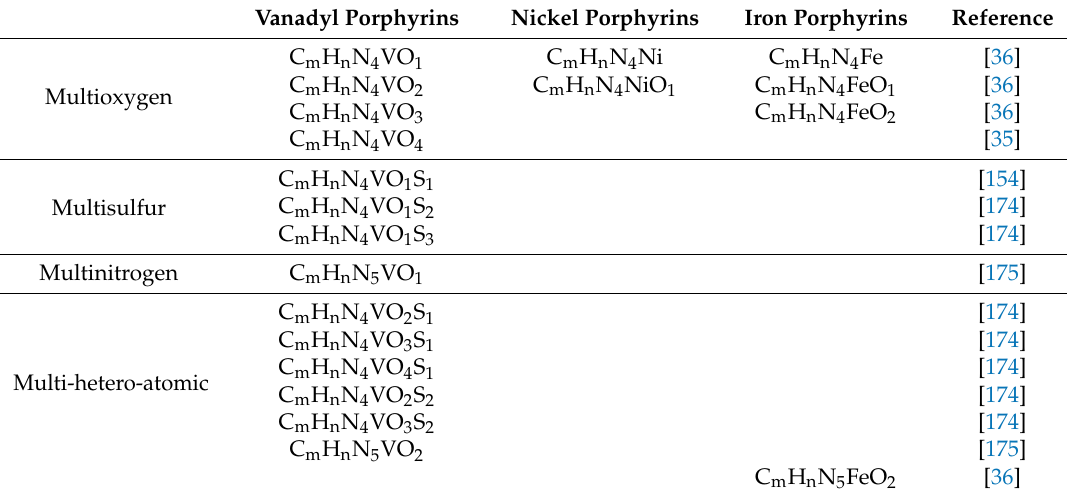
Table 3. Overview of known vanadyl, nickel, and iron petroporphyrin